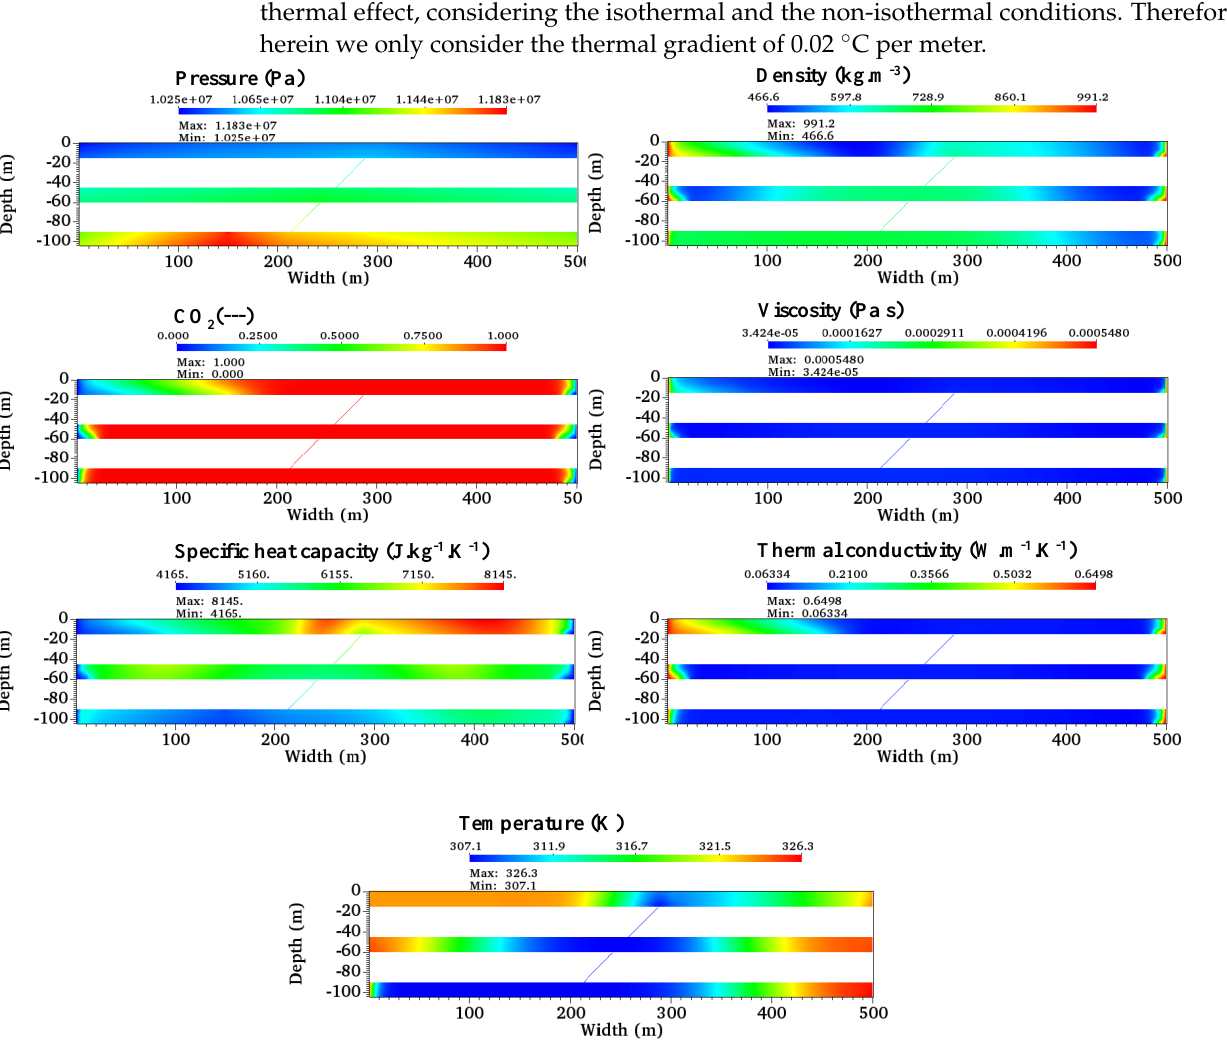
ity, and temperature after 300 days of injection for the case with thermal gradient = 0.03, injection